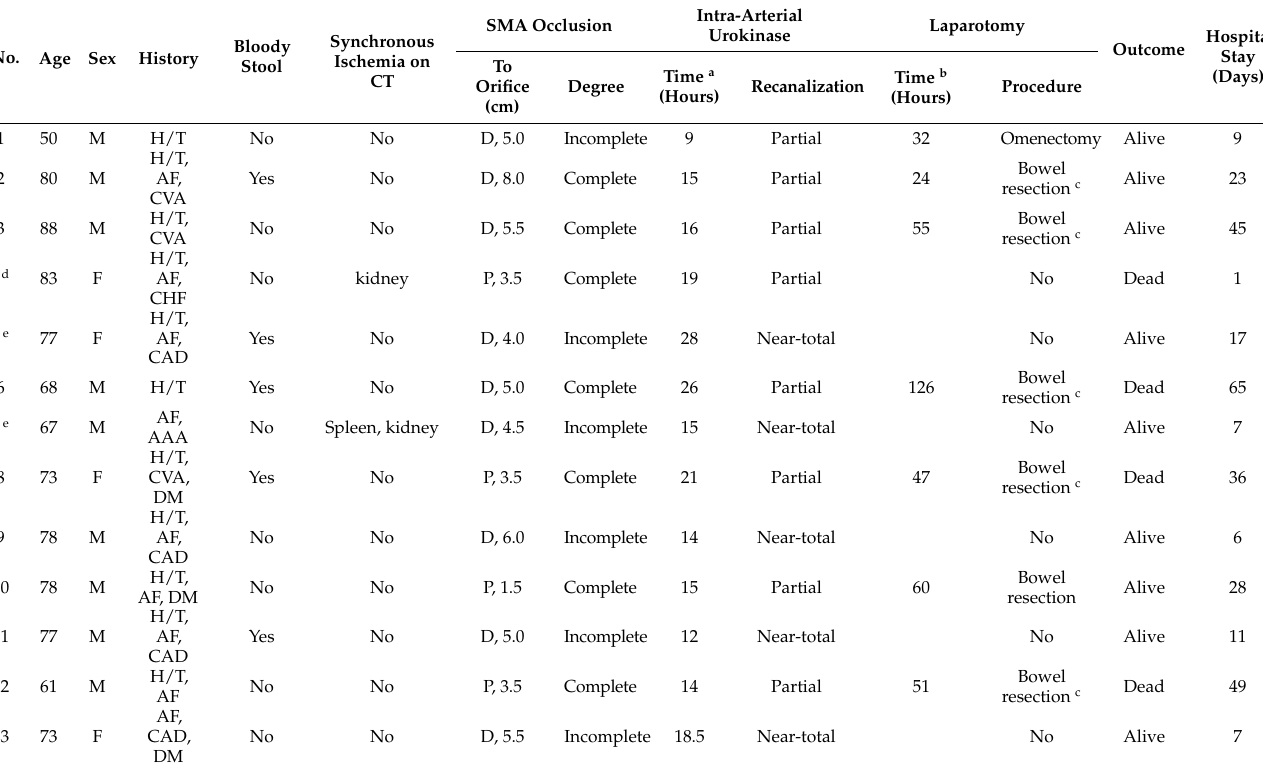
Table 2. Demographic characteristics, clinical presentations, imaging findings, response to urokinase therapy and outcomes of the 13 patients with superior mesenteric artery (SMA)